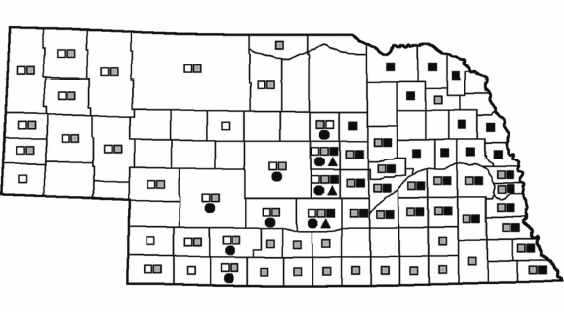
Figure 12: Approximate delineation of hybrid zones in the Cicin- dela splendida group in Nebraska. The occurrence of C. denverensis is depicted by an empty square, C. splendida by a gray square, and C. limbalis by a black square. A black circle indicates presence of C. denverensis × splendida hybrids, and a black triangle indicates the presence of C. limbalis × denverensis hybrids.